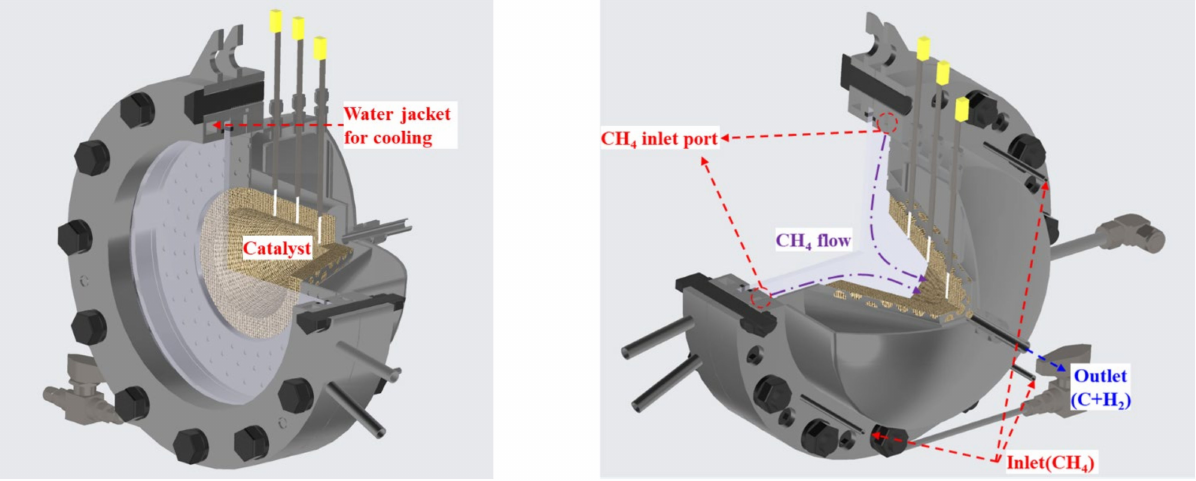
Figure 5. Direct heating reactor model.